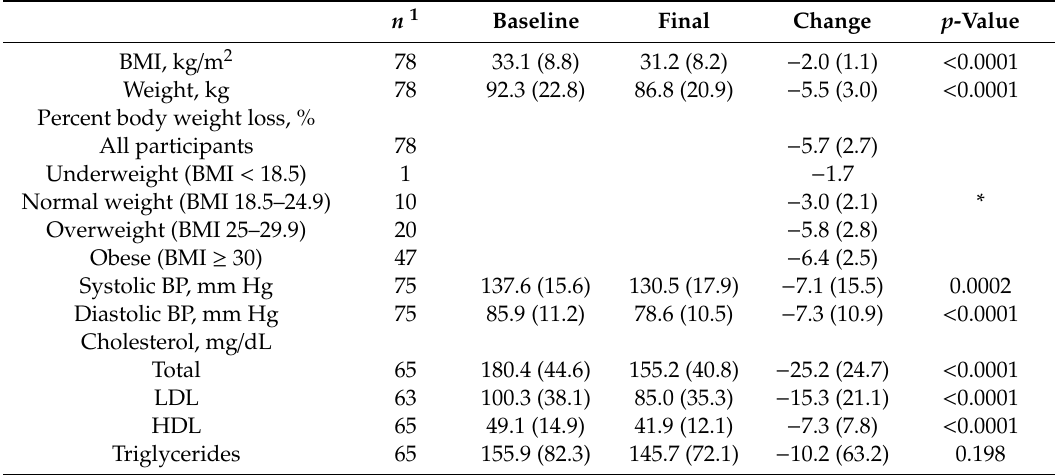
Table 3. Clinical outcomes (average duration of 8.9 ± 1.2 weeks). Data are means ±